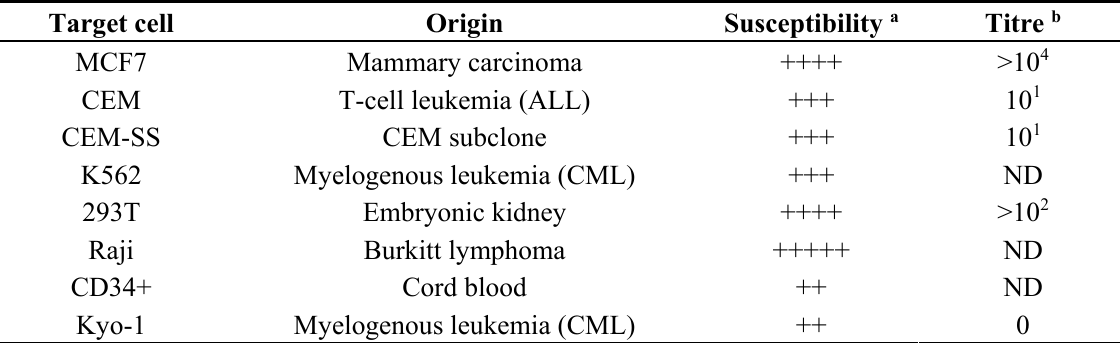
Table 1. Susceptibility of human cells and cell lines to infection with in vivo recovered